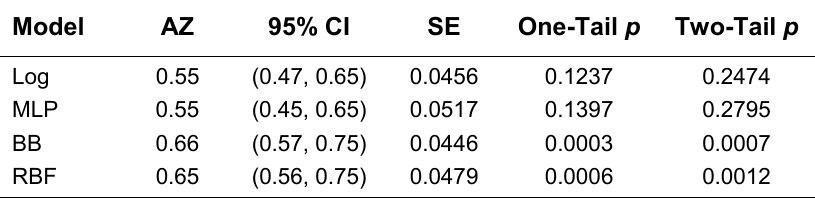
Model Performance Comparison of Area Under the Curve: Administrative and Clinical Data Testing Set — 90-Day